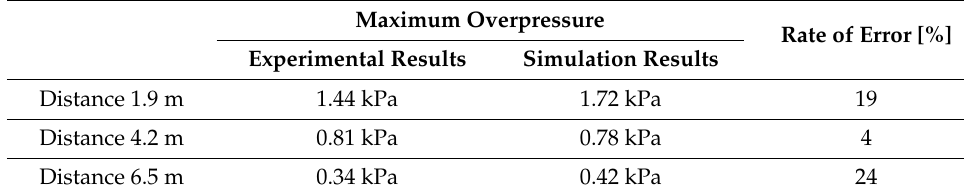
Table 2. Comparison of Maximum Overpressure Experiments and Simulations.